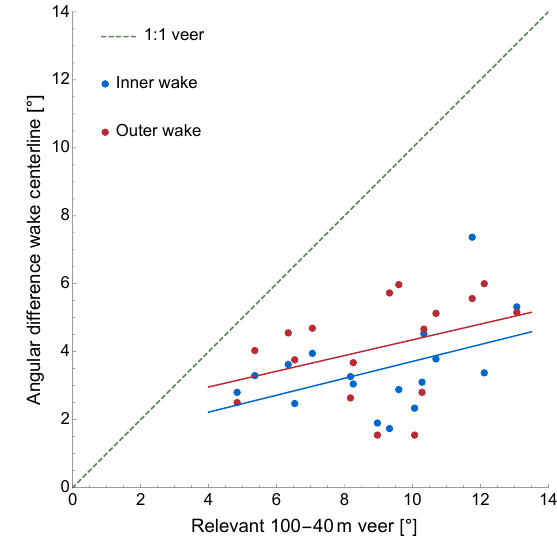
Figure 13. Angular difference between wake centerlines at differ- ent vertical heights (35m < z < 55m and z > 75m) vs. wind veer between 100 and 40m. Data for an inner and an outer wake in the considered row of four turbines, for several 30min time frames dur- ing the nights of 23 and 26 August 2013. Continuous lines are the linear regressions from the data (red best fit: 2.04 + 0.23 x ; blue best fit: 1.23 + 0.25 x ), for the outer and the inner wake. Dashed line highlights the unreached equality between ambient veer and wake centerlines angular